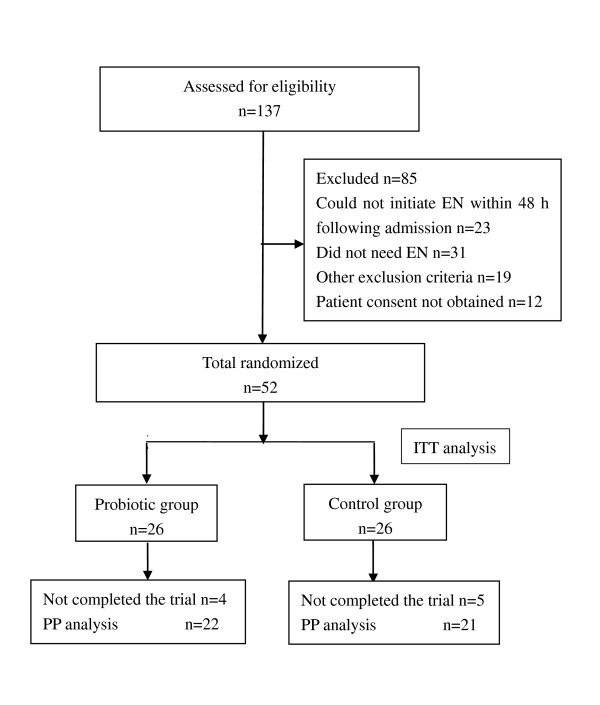
CONSORT flow diagram of the trial. EN, enteral nutrition; ITT, intention to treat; PP, per protocol.